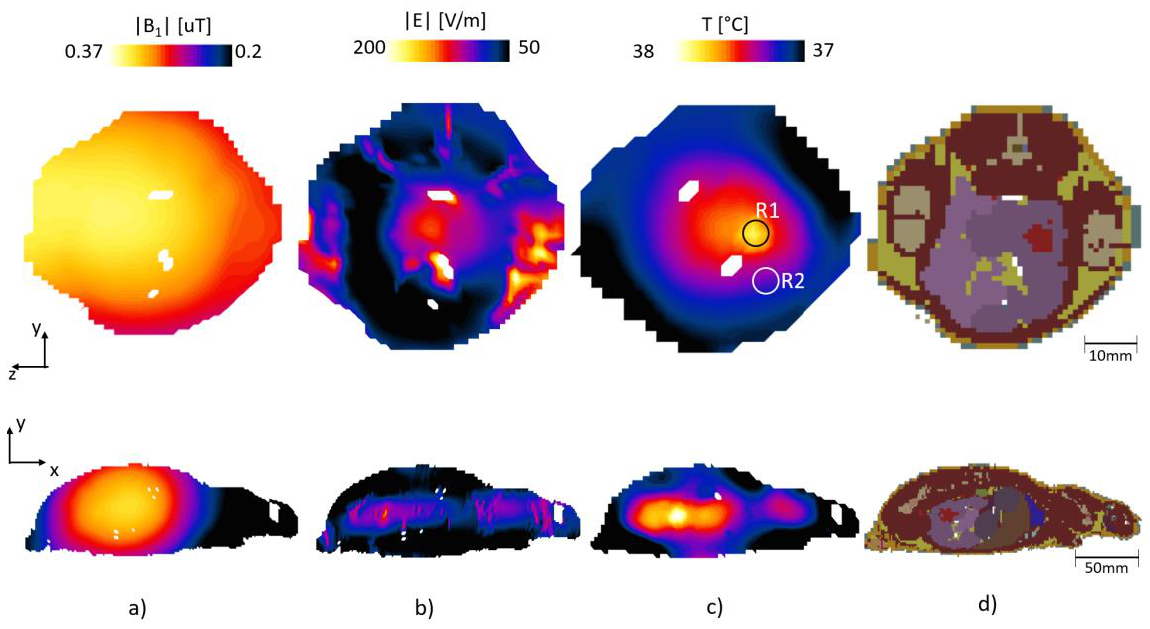
Figure 8. The computed ( a ) |B 1 |-field, ( b ) |E|-field and ( c ) temperature map, for ( d ) voxel of rat model.